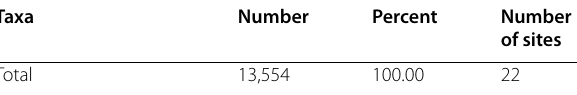
Table 3 Aquatic macroinvertebrates collected from 22 sites on the South Fork Whitewater River, Minnesota,